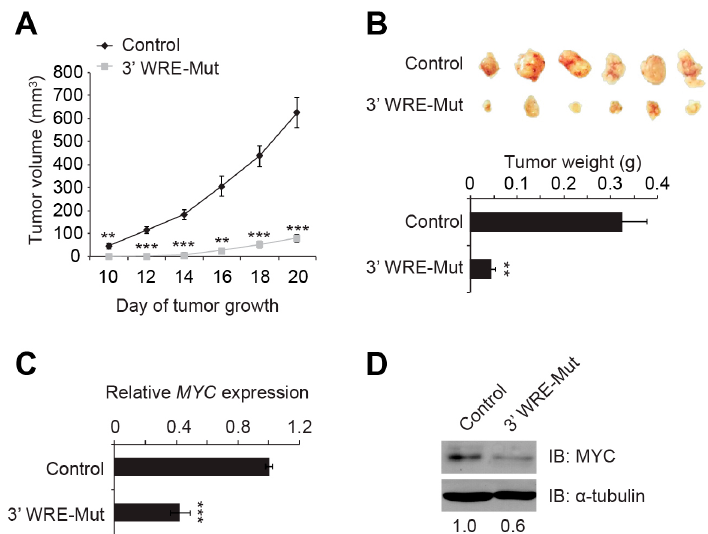
Figure 6. The MYC 3 ′ WRE controls the tumorigenic potential of HCT116 cells in vivo . ( A ) Mouse xenograft assays conducted using control and 3 ′ WRE ‐ Mut cells with tumor volumes indicated on the respective day of measurement; ( B ) images and weights of control and 3 ′ WRE ‐ Mut tumors that were excised on day 20; ( C ) qRT ‐ PCR analysis of MYC transcript levels in tumors explanted on day 20. The data is normalized to GAPDH and represented as levels measured relative to that detected in control tumors; ( D ) Western blot analysis of MYC protein levels in control and 3 ′ WRE ‐ Mut tumors. Shown below are relative levels of MYC that were quantified using ImageJ software and normalized to tubulin levels. Error bars are ±SEM (* p < 0.05, ** p < 0.01, *** p < 0.001).